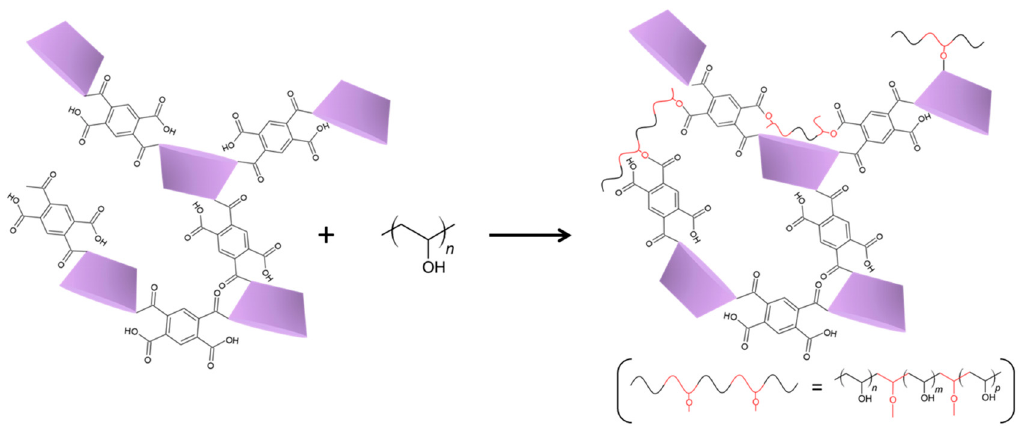
Figure 2. Scheme of the cross-linking reactions between Poly- β CD and PVA during the curing treatment.